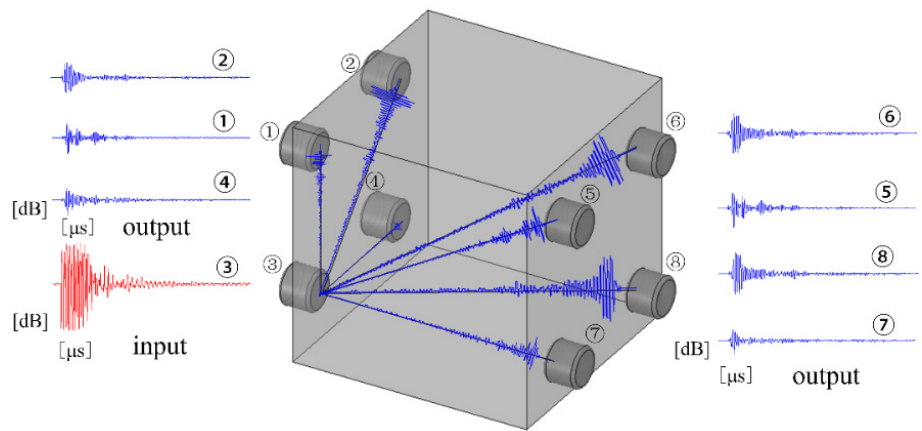
Figure 4. The schematic diagram of AE elastic wave velocity.